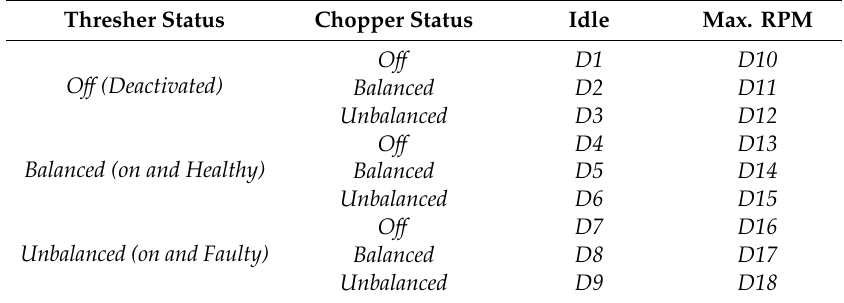
Table 1. Cases studied according to the combination of the component working conditions status (off, balanced, and unbalanced) and velocity (idle and maximum revolutions per minute (RPM)).